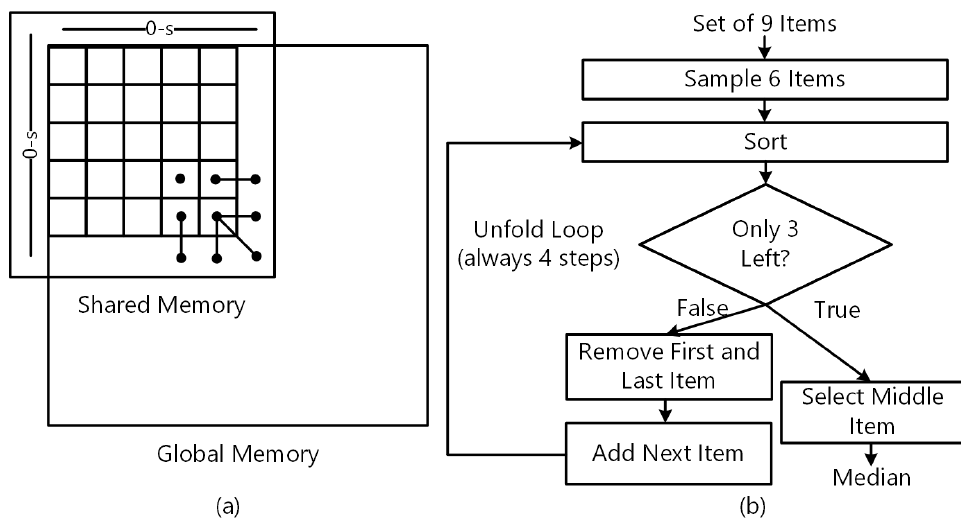
Figure 14. ( a ) Visualisation of caching values from 10 × 10 global memory in (5 + 2) × (5 + 2) shared memory for four bottom right threads. ( b ) Forgetful sorting for 3 × 3 kernel to determine the median